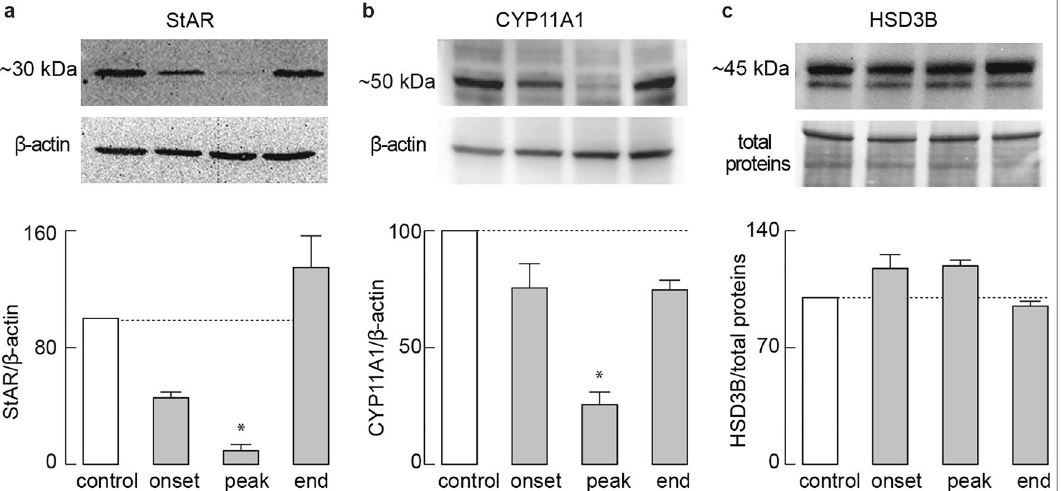
Figure 3. Effects of EAE on the expression profile of testicular steroidogenic pathway proteins. Pooled interstitial cells of 6 animals from each group were analyzed for StAR ( a ), CYP11A1 ( b ), and HSD3B ( c ) proteins via Western blot (40 μg proteins/well). For the quantification of HSD3B, the top bands (~ 45 kDa) were used. StAR and CYP11A1 were determined relative to β-actin, while HSD3B levels were determined relative to total protein stain. Top panels: representative blots (unprocessed images available in Supplementary figure). Bottom panels: mean ± SEM (from three Western blot experiment values), optical density values were normalized to the control group (100%).* P < 0.05, via Kruskal–Wallis test, followed by Dunn’s post hoc test. The figure was made using KaleidaGraph (version 4.1.0; http:// www. syner gy. com) and Illustrator (version 25.1.0; http:// www. adobe.